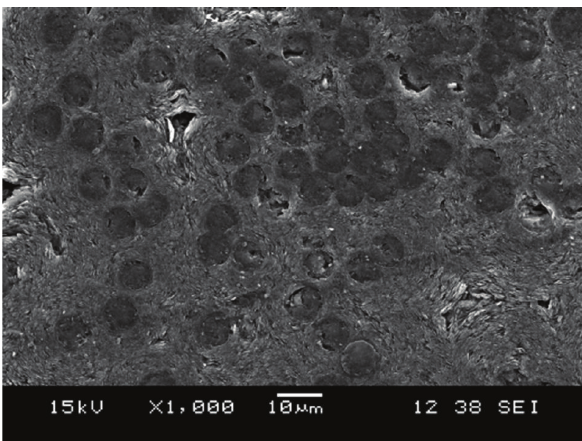
Figure 1: SEM micrograph of the C/C composites.